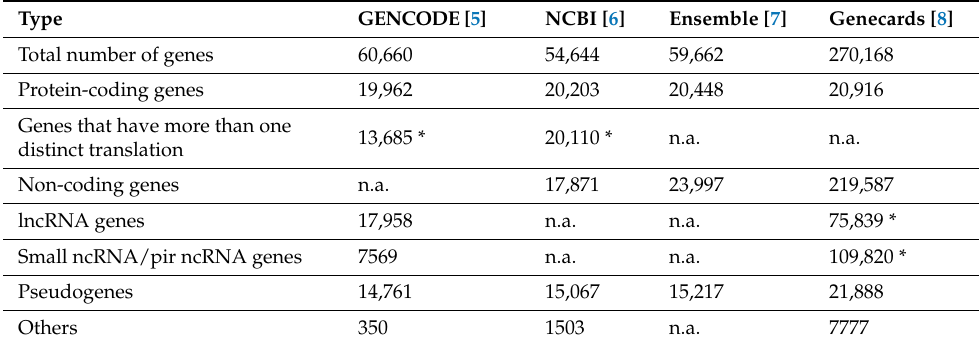
Table 1. Number of genes in the human genome as of